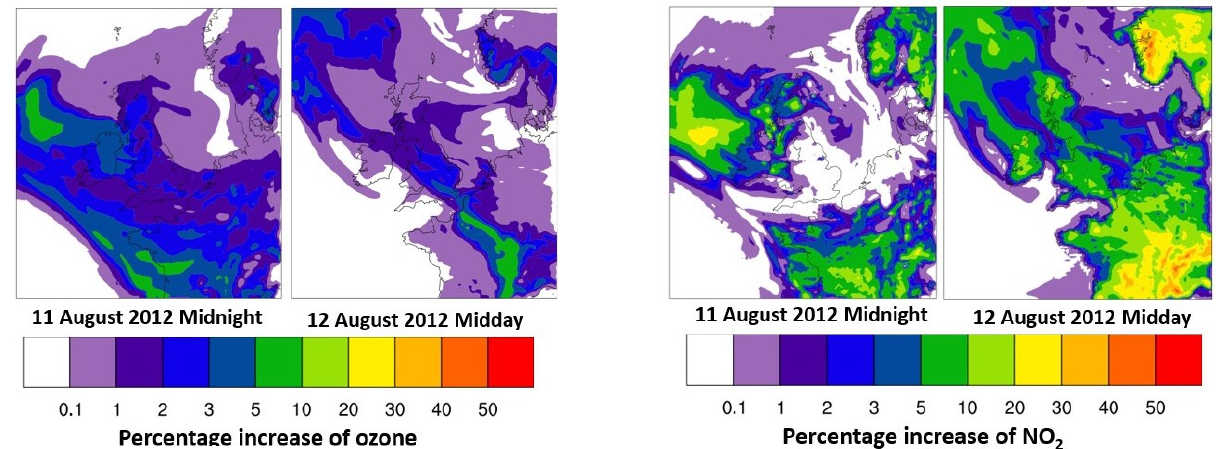
Figure 4. Percent increases of surface ozone and NO 2 mixing ratios from WRF-Chem-CRI to WRF-Chem-CRI-WON at 11 August 2012 midnight and 12 August 2012 midday. Note: Percent increase = (WRF-Chem-CRI–WRF-Chem-CRI-WON) × 100)/WRF-Chem-CRI-WON.